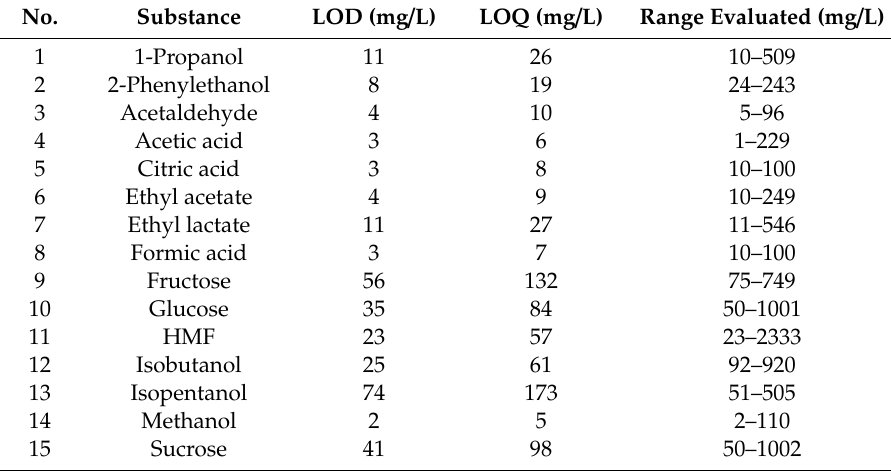
Table 4. Analytical limits for the validated analytes (in mg / L). LOD: limit of detection.